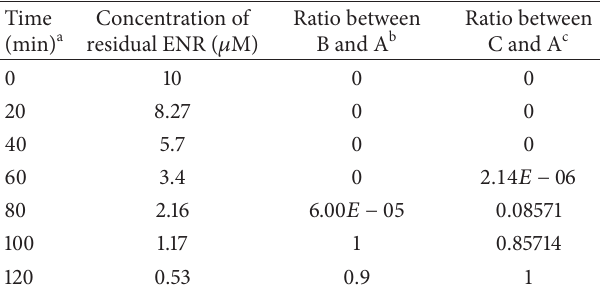
Table 1: The E. coli DH5 𝛼 CFU ratio between solutions B and C and solution